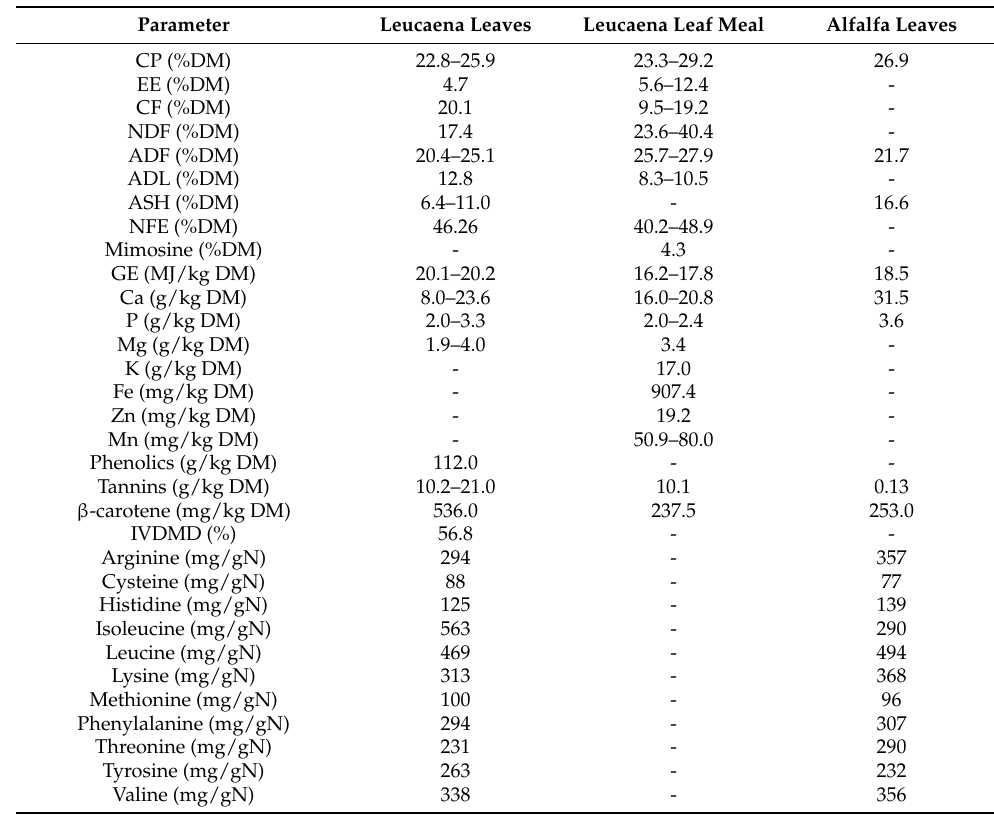
Table 2. Chemical composition of Leucaena leaves [33,41–43] and leaf meal [32,44–47] in comparison with Alfalfa leaves